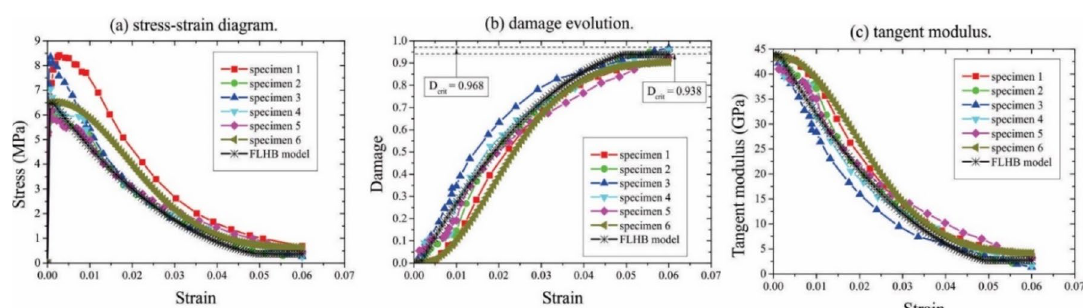
Figure 1. Tensile test at room temperature of UHPFRC with 2% of fibers [30]: (a) stress-strain diagram; (b) damage evolution and (c) tangent modulus.